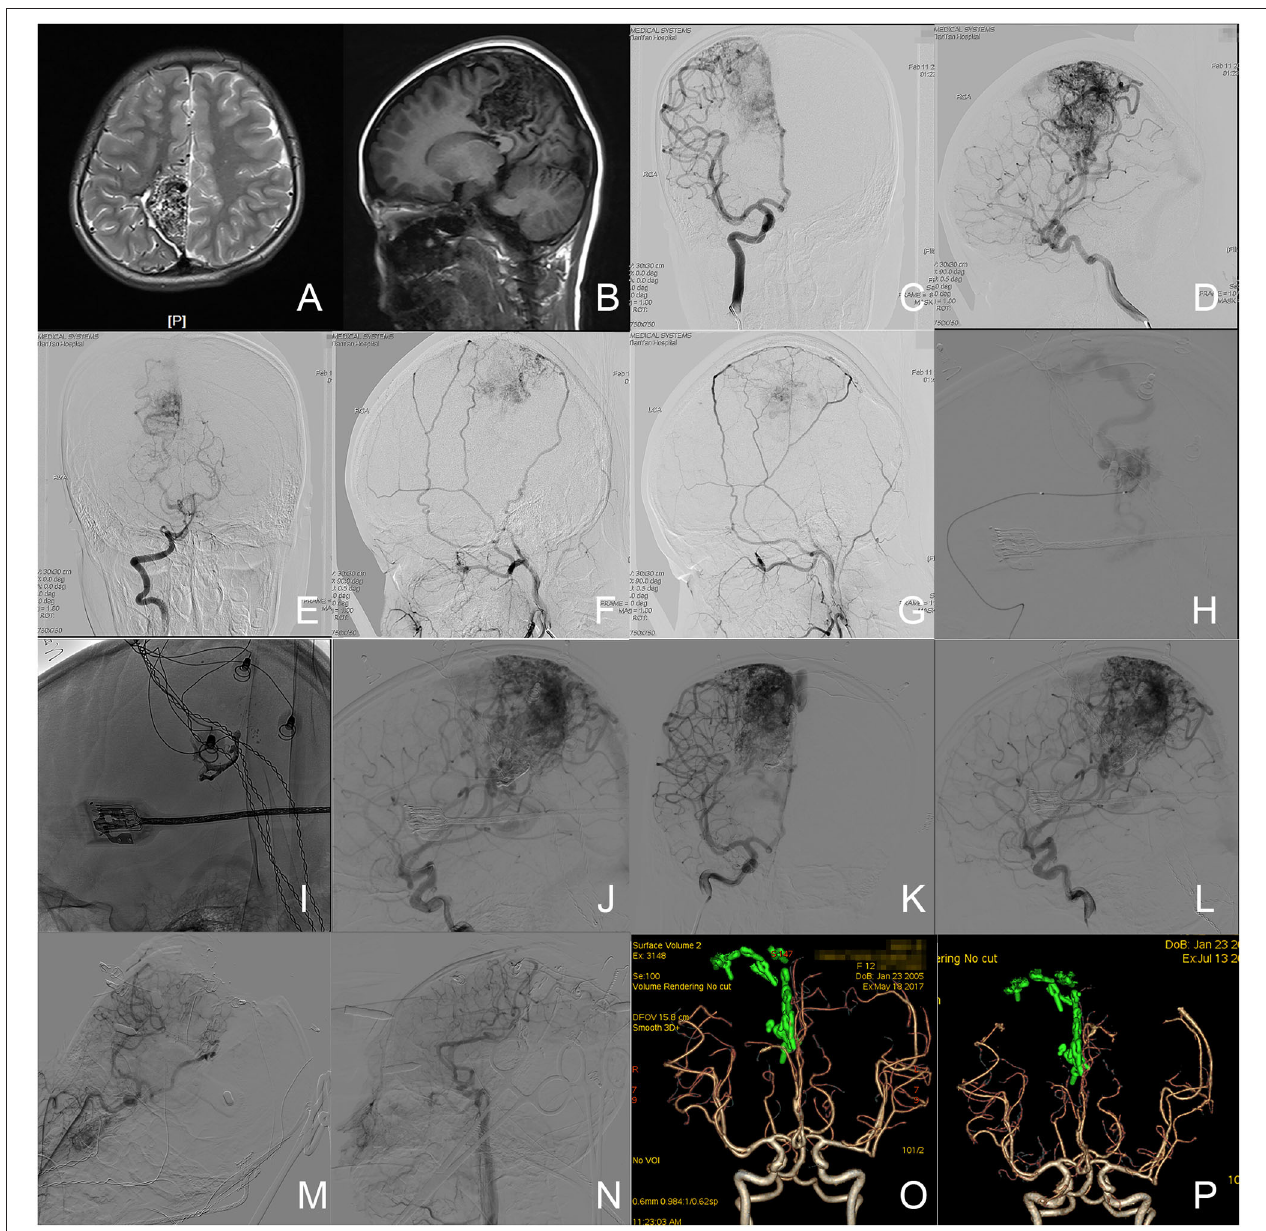
FIGURE 1 | Illustration of case 4. (A,B) The axial T2-weighted and sagittal T1-weighted MR images revealed a cerebrovascular lesion in the right parietal lobe with isthmus of cingulate gyrus, parahippocampal gyrus, and splenium of corpus callosum involved. (C,D) Angiograms of right internal carotid artery (ICA) revealed the arterial feeders from the right arteries of central and postcentral sulcus, and the right pericallosal artery, paracentral artery, and precuneal artery, as well as drainage through Galen’s vein and superficial draining vein. (E) Angiogram via the right vertical artery revealed the arterial feeders from the right posterior cerebral artery. (F,G) Angiograms via the bilateral external carotid arterial revealed the arterial feeders from the bilateral middle meningeal arteries. (H) An angiogram through the microcatheter (Excelsior SL-10, Stryker Neurovascular, California, USA) in the right pericallosal artery. (I) The casted embolization agent (high density object). (J) Angiogram through the right ICA in the work position after embolization. (K,L) The angiograms through the right ICA before microsurgery revealed the partial occlusion of nidus and feeder in the deep. (M,N) The intraoperative angiogram before closure confirmed the complete elimination of nidus. (O) The follow-up CTA 3 months after the operation revealed a complete elimination of nidus. (P) The follow-up CTA 17 months after the operation revealed no residue or recurrence. The green objects in (O,P) were the reconstructed clips.